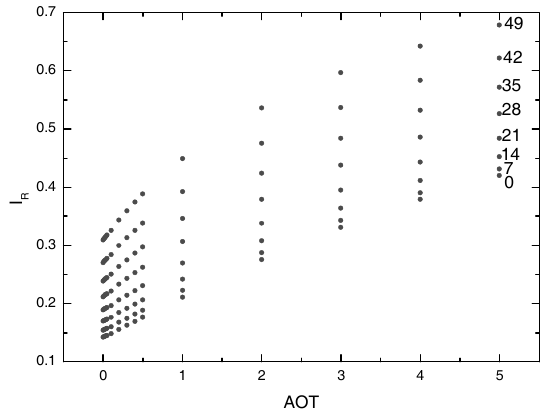
Fig. 5. The dependence of the first normalized Stokes vector com- ponent at λ = 412 nm, the solar zenith angle 60 ◦ , and the relative azimuth 180 ◦ on the viewing zenith angle for the aerosol model de- scribed in Sect. 2. The aerosol is contained in the plane-parallel layer positioned in the region 0–2km above the black underly- ing surface. The molecular scattering is taken into account. The gaseous absorption is neglected. The aerosol optical thickness at 412nm is assumed to be equal 0, 0.01(0.01)0.05, 0.1(0.1)0.5, 1, 2, 3, 4, 5. The lower lines correspond to the smaller values of AOT.